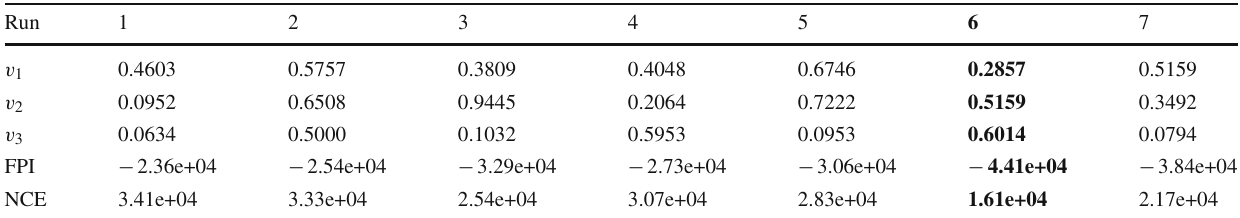
module, the Euclidean distances are computed from the optimized cluster centers by utilizing Eq. (5). These dis- tances are then compared with a lower threshold α L and an upper limit α U for discriminating the test instances